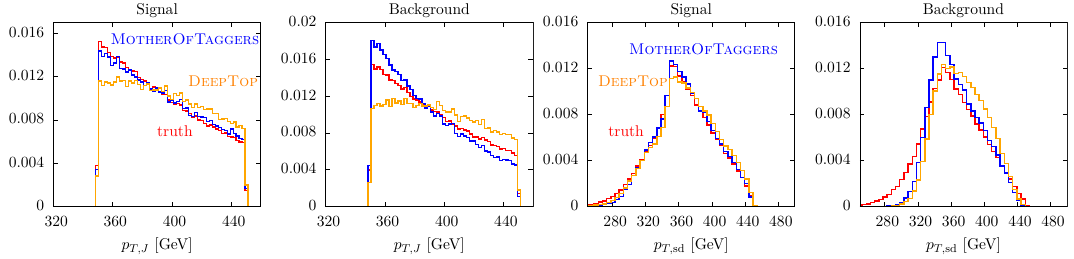
Figure 11 . Reconstructed transverse momenta for events correctly determined to be signal or background by the DeepTop neural network and by the MotherOfTaggers BDT, as well as Monte Carlo